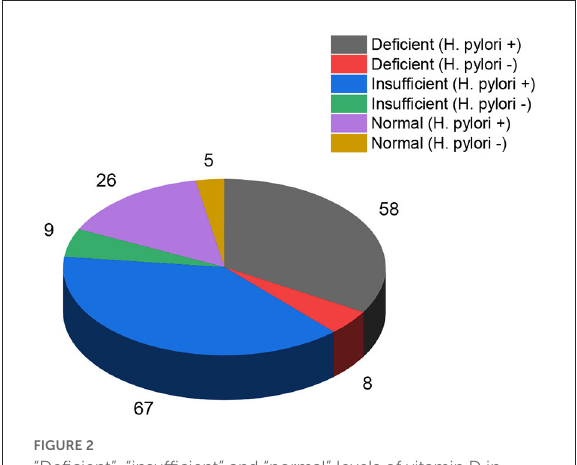
FIGURE3 Vitamin D levels in all serotypes of dengue fever patients. Orange color represents DENV 1, purple shows DENV 2 while maroon DENV 3 and turquoise depict DENV 4 serotypes.